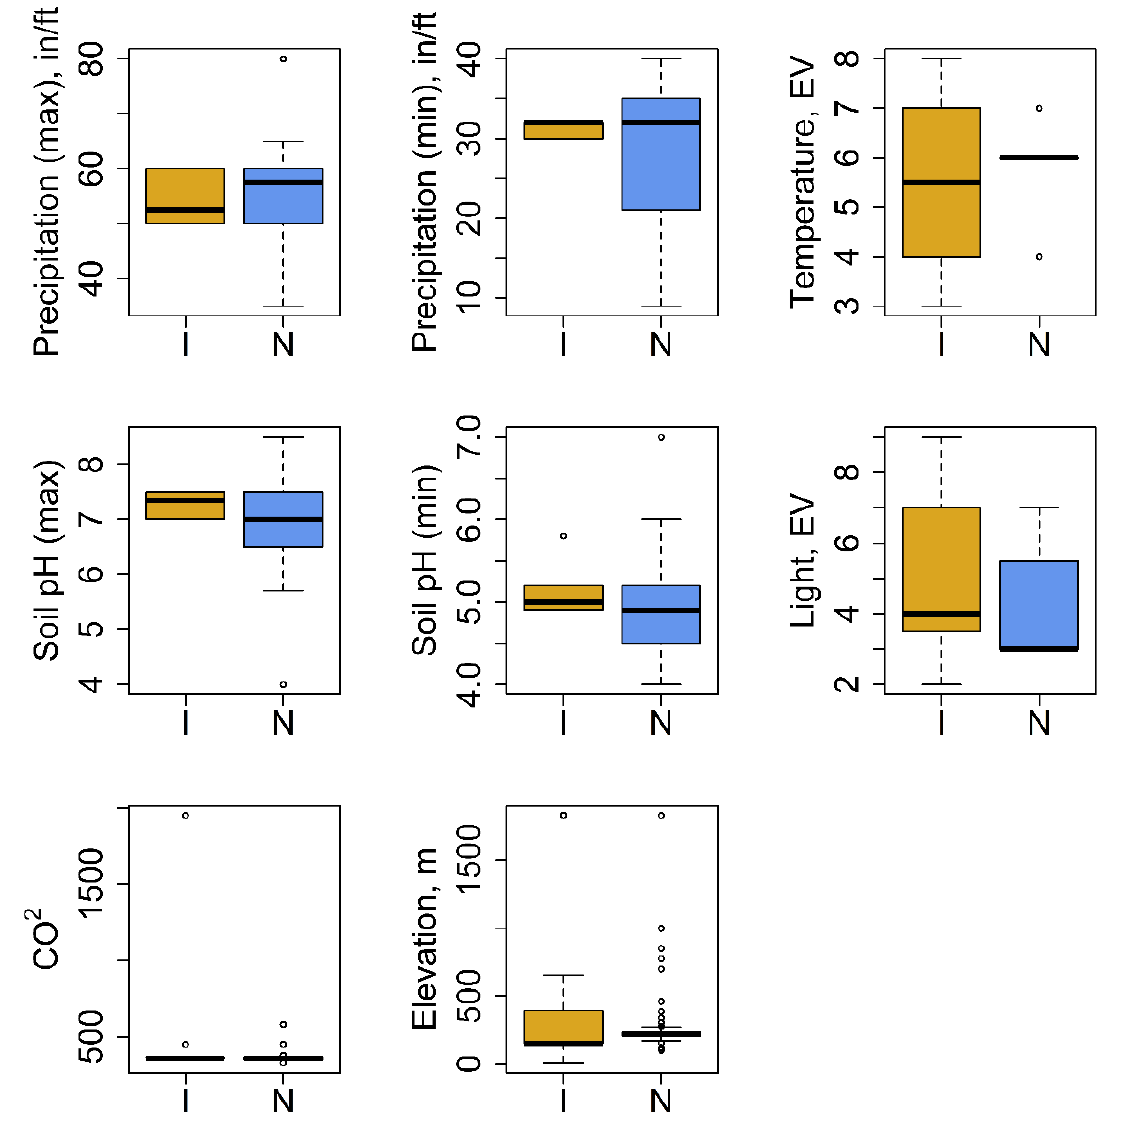
Figure 3. Plant species habitat characterization and plant environmental requirements compared between native (N) and introduced (I) host plants of Lycorma delicatula . The trait names are as follows (from left to right, and from top to bottom): Precipitation (max); Precipitation (min), Temperature: species environmental indicator value according to Ellenberg (EV, Ellenberg Value); Soil pH (max); Soil pH (min); Light: species environmental indicator value according to Ellenberg (EV, Ellenberg Value); Atmospheric CO 2 concentration (ppm); Elevation. Boxplots represent the median (thick horizontal line), the 25th and 75th percentiles (the box), the 5th and 95th percentiles (the whiskers). No significant differences between native and introduced host plants were detected at α = 0.05.